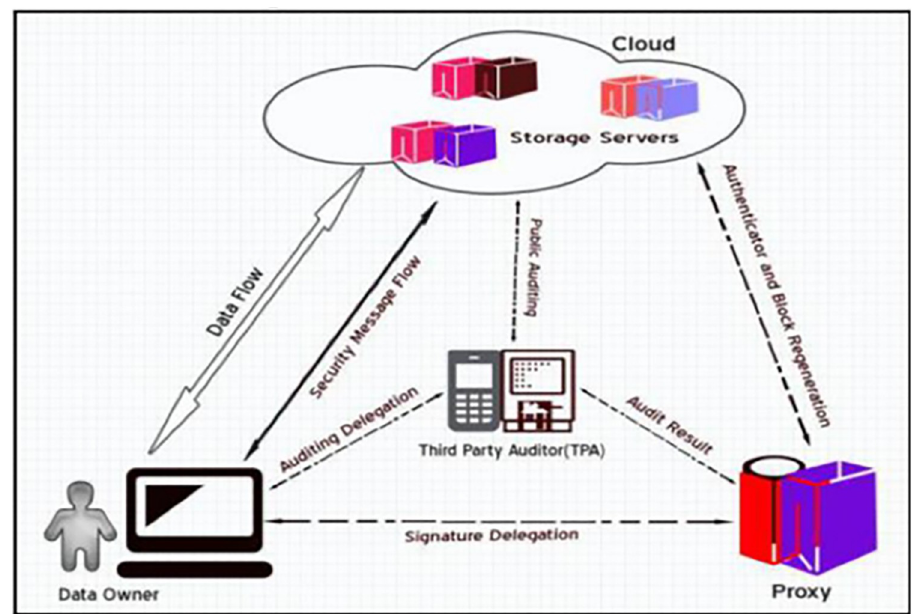
Fig 3. Privacy structure in the cloud